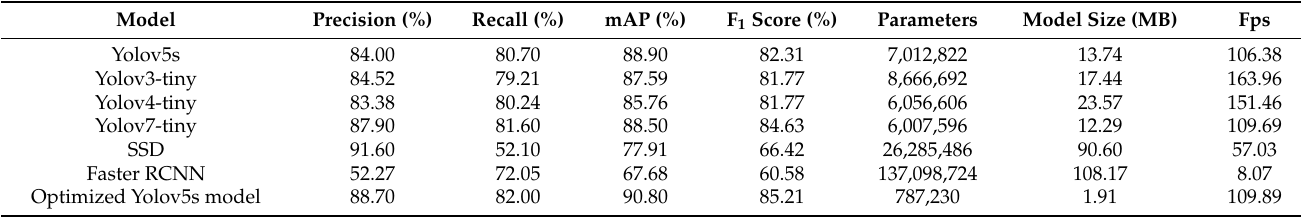
Table 5. The model performance with different